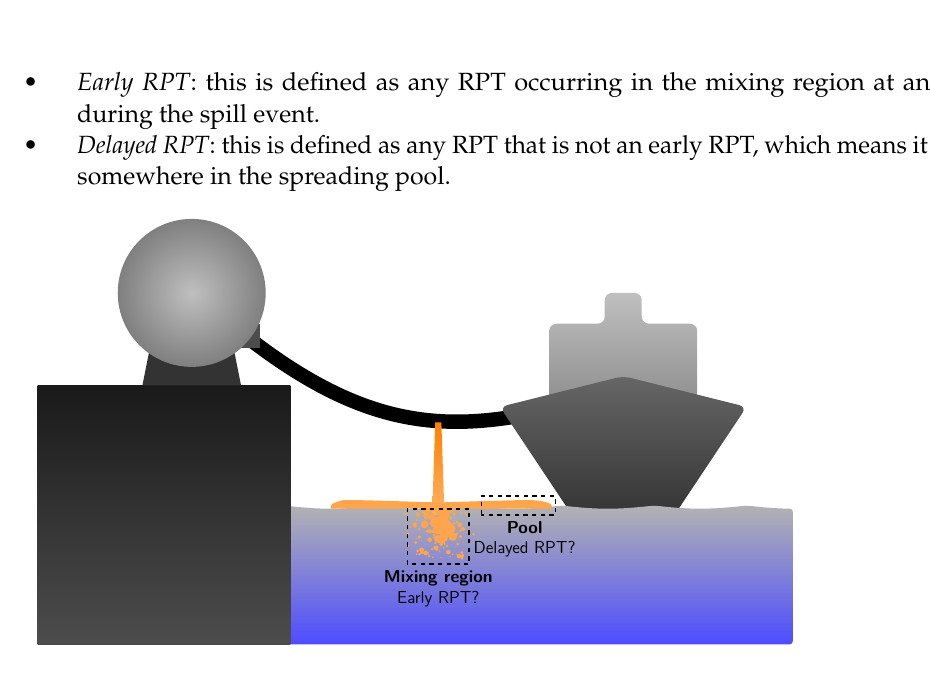
Figure 1. An illustration of an accidental release of a cryogenic fuel onto water. The origins of two kinds of RPT events are also shown: early RPT from the mixing zone and delayed RPT from the spreading pool.